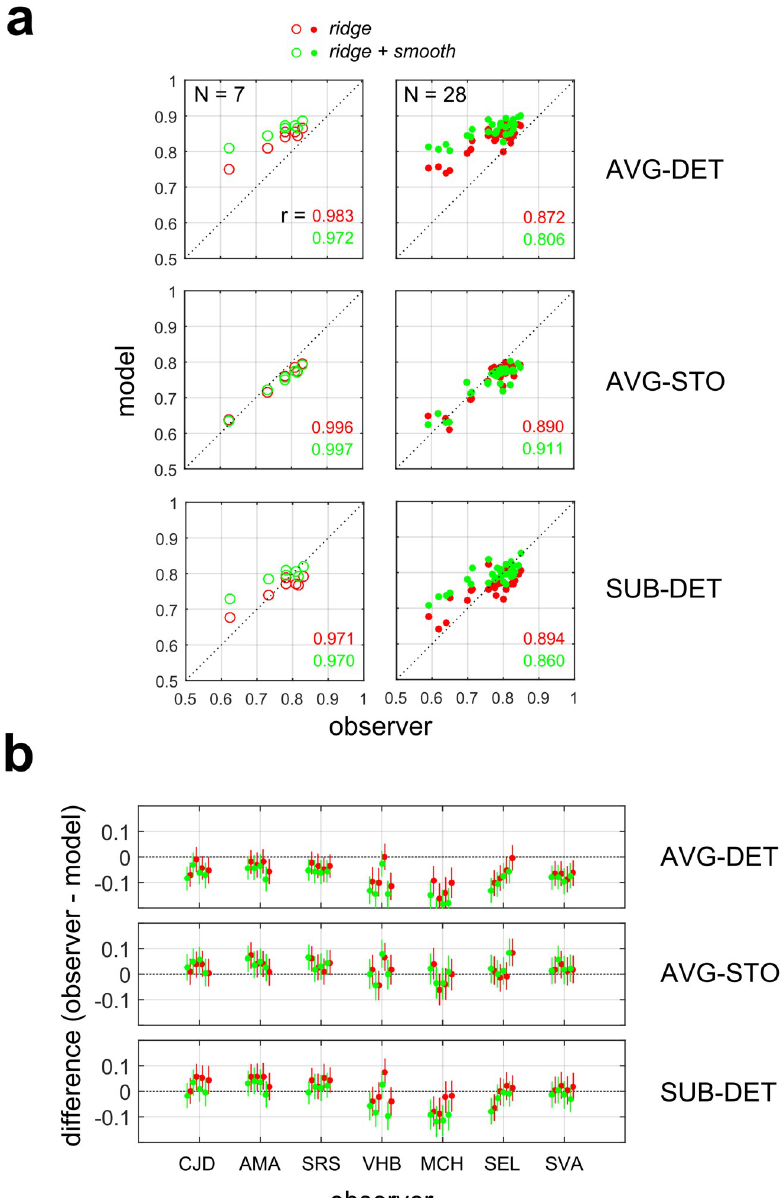
Fig 7. Analysis of model accuracy for Experiment 1-VAR. ( a ) Plots of model vs. observer performance (proportion correct), averaged across observers (left sub-panels, circles, N = 7) or test folds (right sub-panels, solid symbols, N = 28). Observer and model performance were compared on a set of novel test stimuli (N = 500) not used for model estimation or hyper-parameter optimization. Top : Deterministic model with AVG (average) downsampling (AVG-DET). Correlation coefficients (r values) are color coded for each choice of Bayesian prior (red: ridge ; green: ridge + smooth ). Middle : Stochastic model with AVG downsampling (AVG-STO). Bottom : Deterministic model with downsampling implemented with subsampling (SUB-DET). ( b ) Difference between observer and model performance for each individual test fold (4 folds per observer) for all models shown in (a). Lines show 95% confidence intervals of the difference (binomial proportion difference test). Colors indicate different choices of Bayesian prior (red: ridge ; green: ridge + smooth